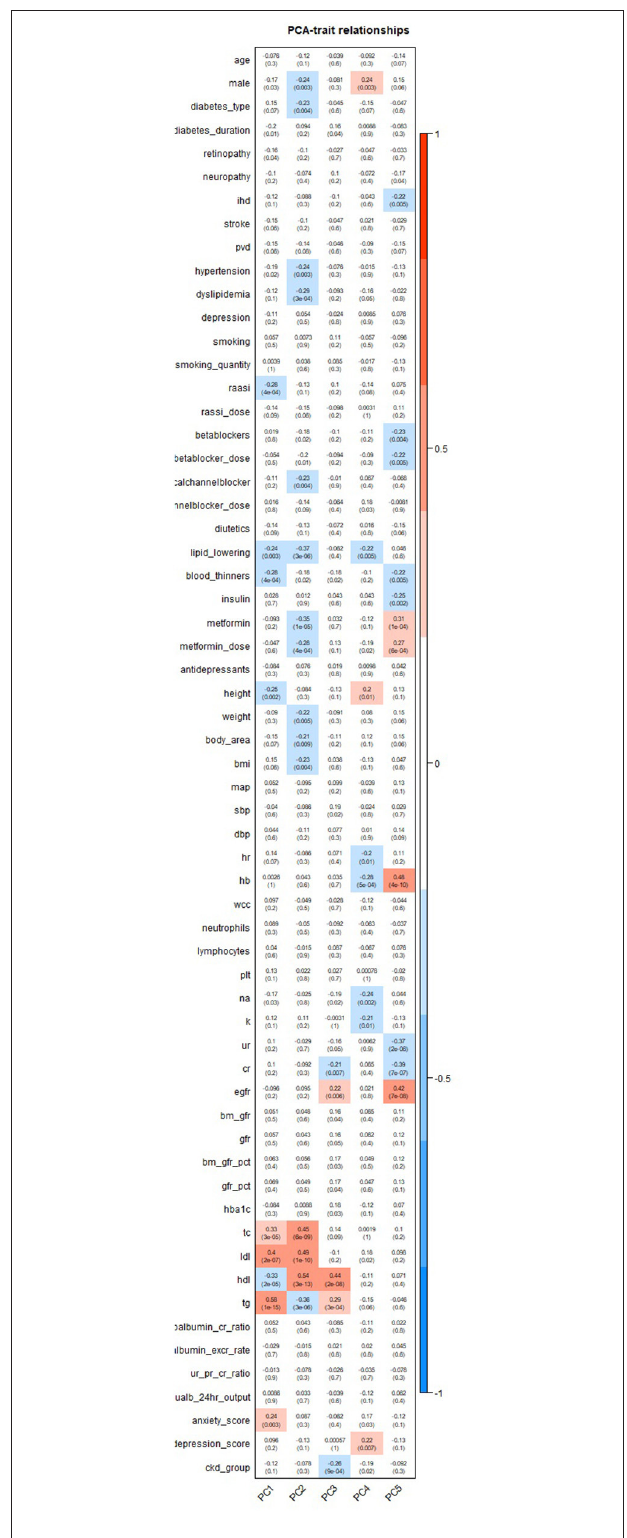
FIGURE 2 | Heatmap illustrating the correlation of principal components with clinical and biochemical